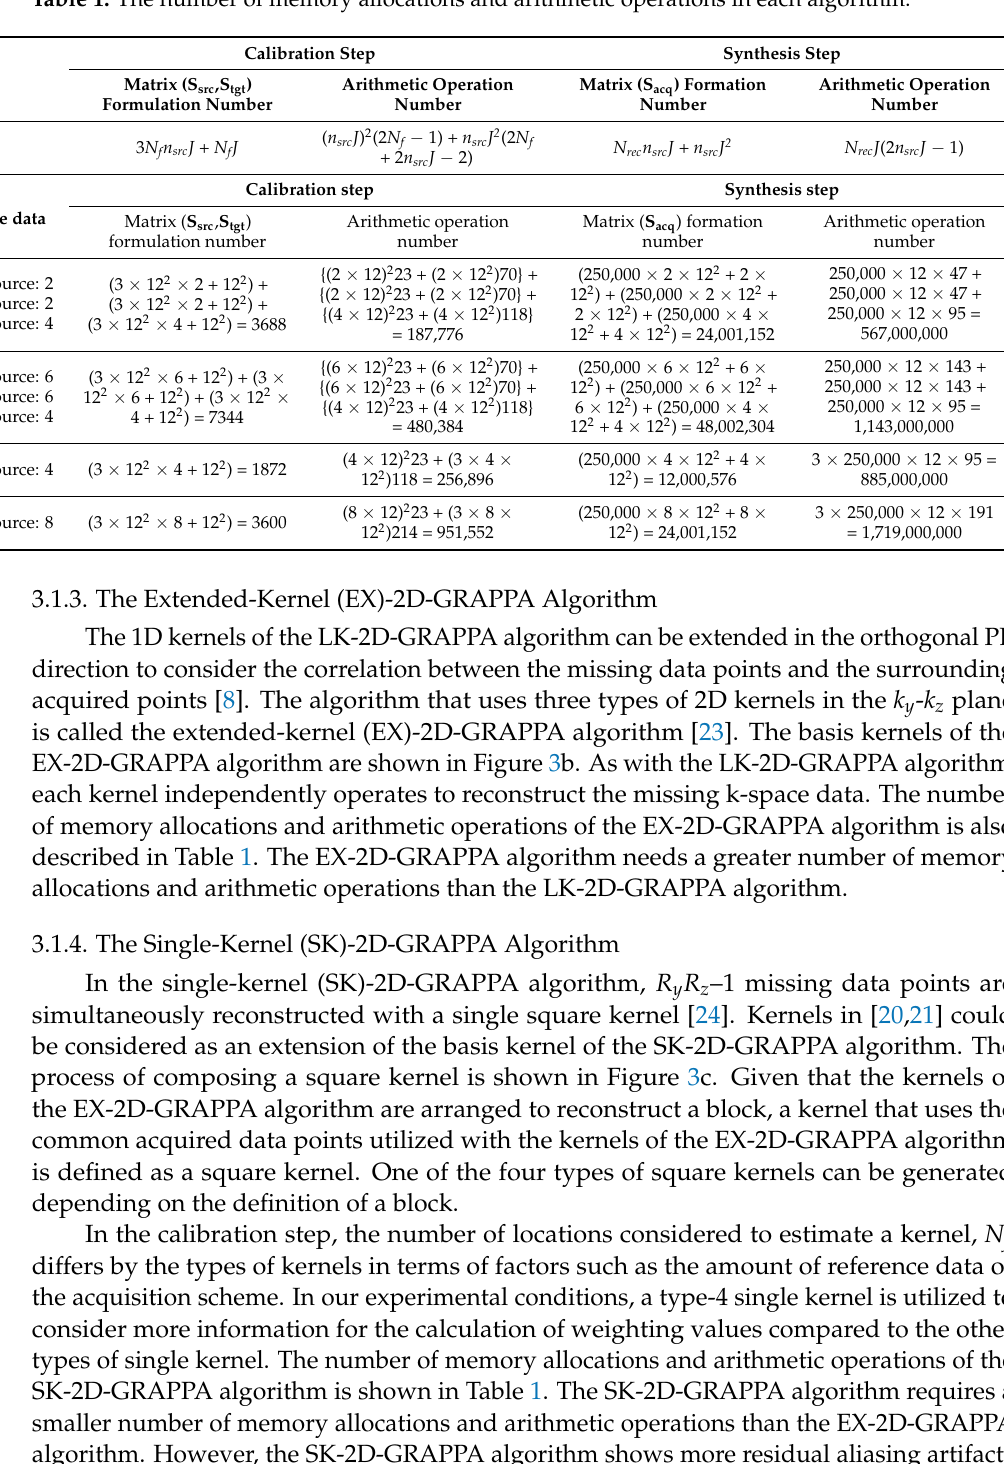
Table 1. The number of memory allocations and arithmetic operations in each